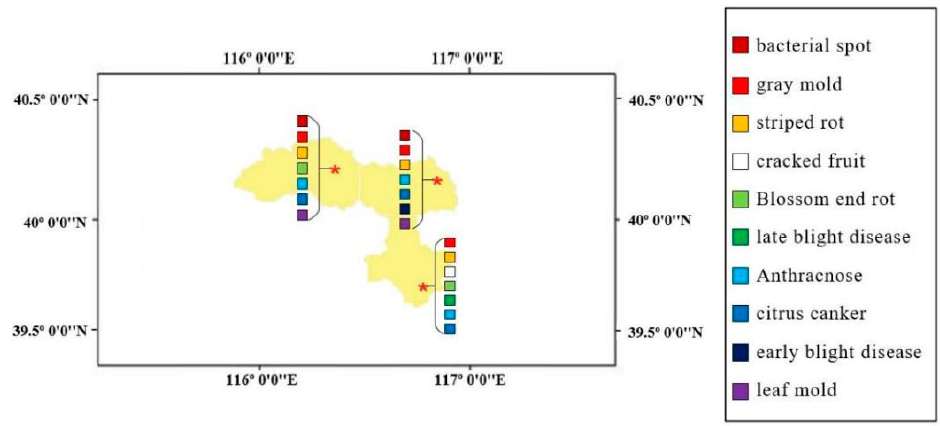
Figure 10. Multiple diseases in different regions. * sign represents tomato data collection area in Beijing. Table 6. Comparison of plant disease classification reports generated from 5-fold cross-validation. The average precision, recall, and F 1 − Score are reported for each class obtained with the ShuFormer- base